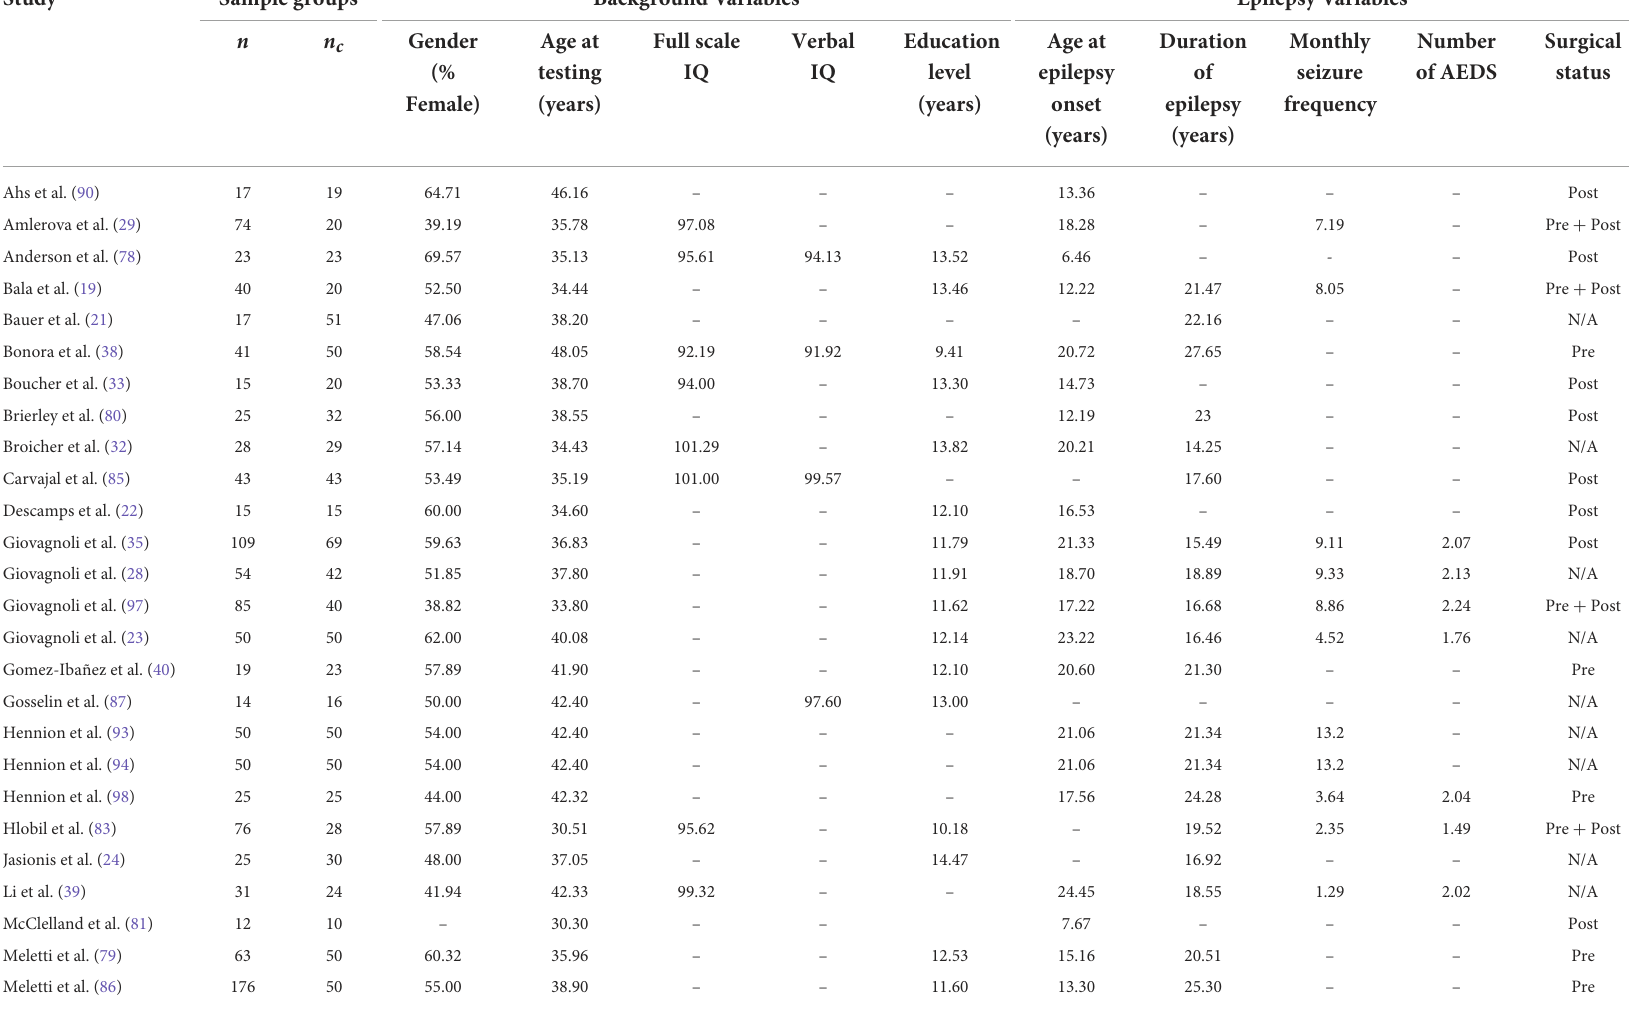
TABLE 1 Characteristics and patient demographics of studies included in the